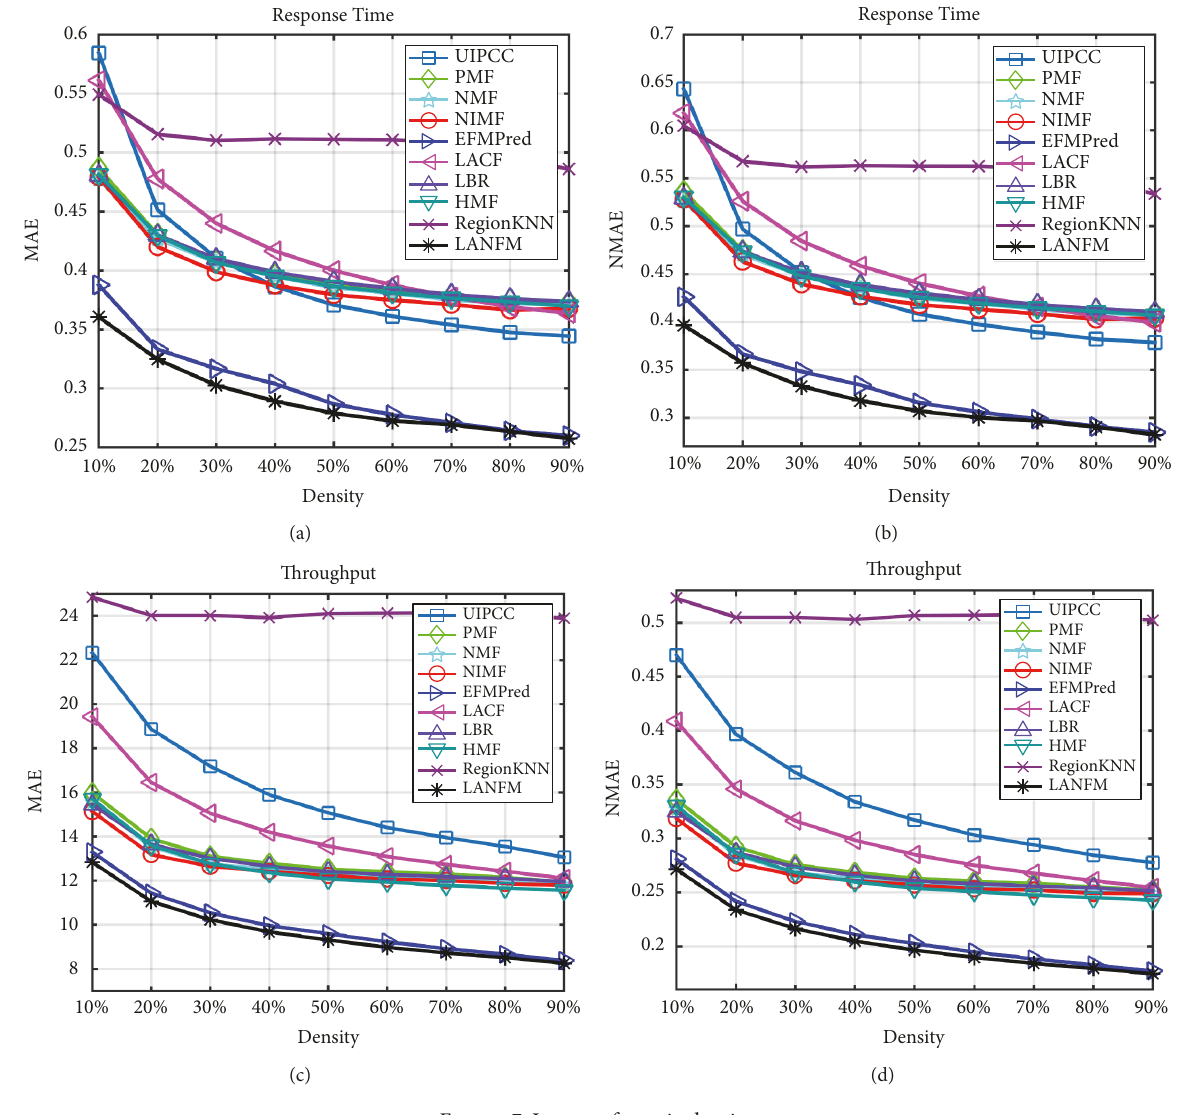
Figure 7: Impact of matrix